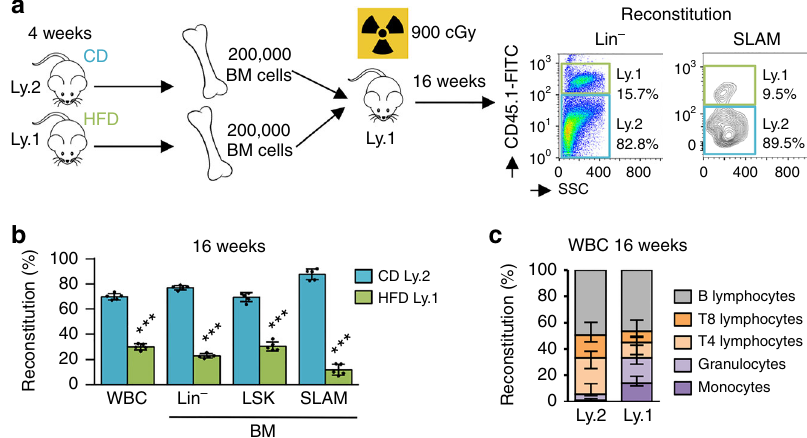
Fig. 4 Erosion of HSC from BM after HFD follows a cell-autonomous response. a Experimental work fl ow. b Competitive transplantation in lethally irradiated recipient mice showing reduced reconstitution of HSC from Ly.1 HFD-fed mice, compared with HSC from Ly.2 CD-fed mice, 16-weeks after the transplantation. Reduced reconstitution is characterized in WBC and different subpopulations of the primitive hematopoietic compartment in BM, n = 5 recipient mice. c HSC from Ly.1 HFD-fed mice reconstitutes more in monocytes and granulocytes, with a reduced reconstitution of T4 and T8 lymphocytes, n = 5 recipient mice. Data show mean ± SD; *** P < 0.001 (two-tailed unpaired Student ’ s t